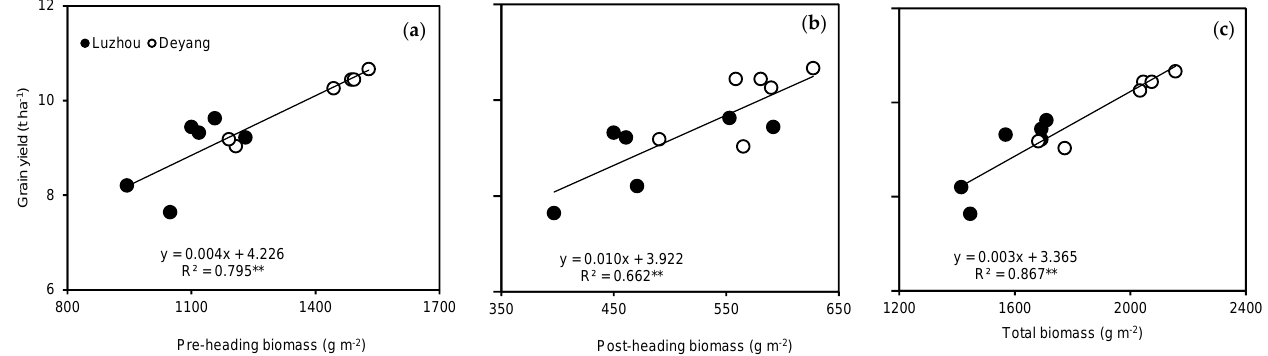
Figure 3. Relationships between grain yield and pre-heading biomass ( a ), post-heading biomass ( b ), and total biomass ( c ) in six rice cultivars grown at two locations from 2018 to 2020. Data are averaged across three years. ‘**’ denotes a significant relationship at the 0.01 probability level. Table 5. Biomass production, biomass remobilization, and harvest index of six rice cultivars grown under two different ecological conditions in a field experiment from 2018 to 2020.